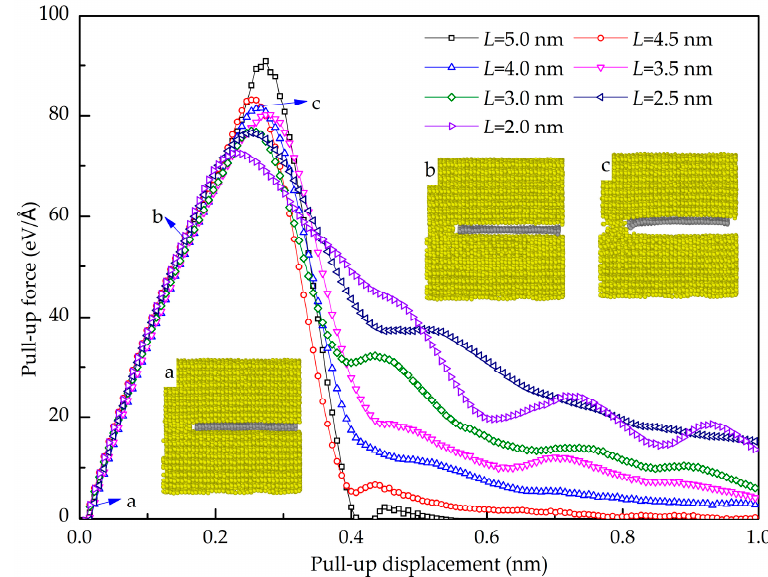
Figure 6. Pull-up force-displacement curves for the Gr/Al composites with different embedded length of graphene and the structural deformation diagram at different stage.